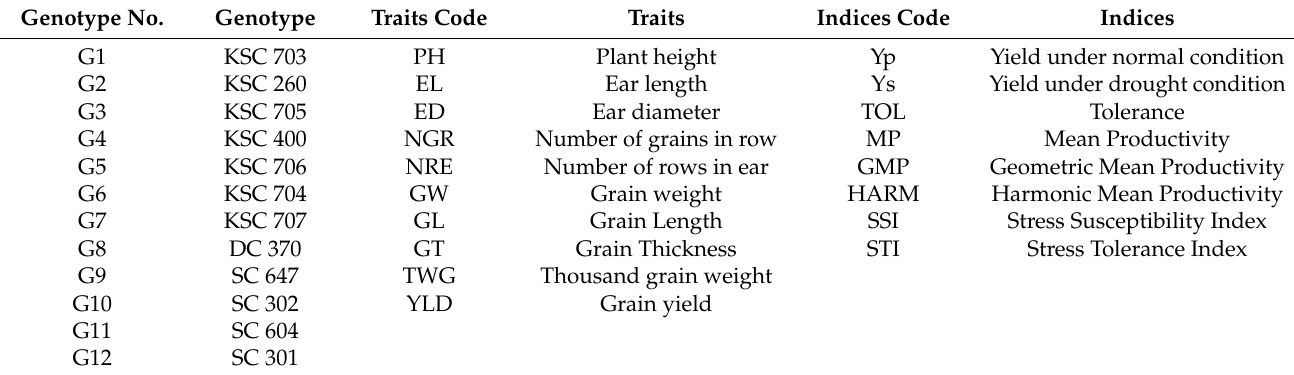
Table 8. Name and code of hybrids, traits and drought-tolerance indices studied in the experiment. Genotype No. Traits